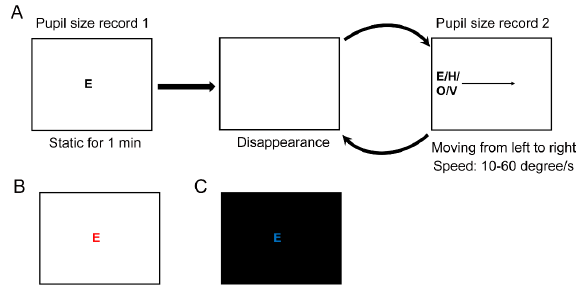
Figure. 1 Paradigms and stimuli. The flow chart of the paradigm and stimuli in experiments 1 and 2. A. The flow chart of Experiment 1. B. The cone-mediated stimulus and background in experiment 2. C. The rod-mediated stimulus and background in experiment